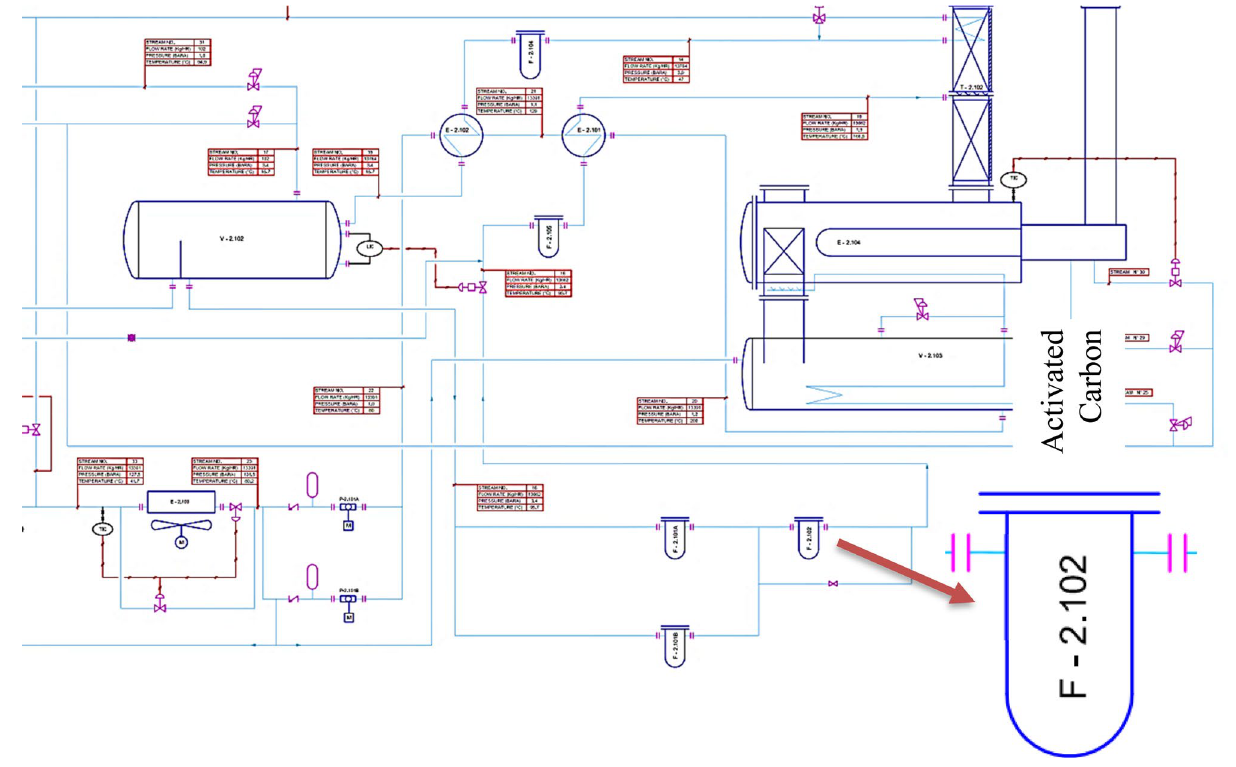
Figure 1. Schematic of unit